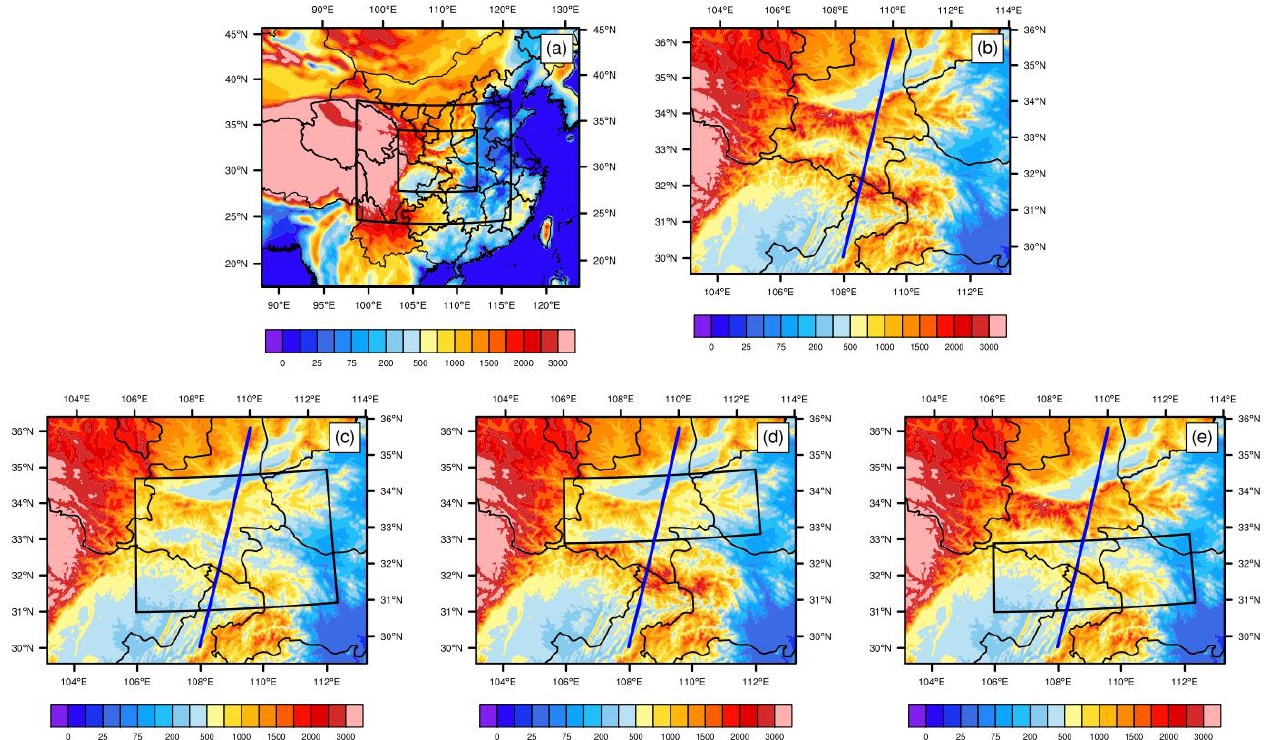
Figure 1. Configuration of model domains and the altitude (shaded, in m) of the orography in each run. ( a ) Geographic location of the three model domains, whose spacings are 27, 9, and 3 km, respectively. ( b ) The orography of the innermost domain of the control experiment (CTRL). ( c ) The orography of the innermost domain of the experiment with both lowered Qinling Mountains and Daba Mountains (LowQD). ( d ) The orography of the innermost domain of the experiment with lowered Qinling Mountains (LowQ). ( e ) The orography of the innermost domain of the experiment with both lowered Daba Mountains (LowD). The black boxes in c-d are the area for lowered mountains. The blue lines indicate the location of the vertical cross sections shown in latter figures, due to the precipitation difference is mainly reflected on the north-south direction.